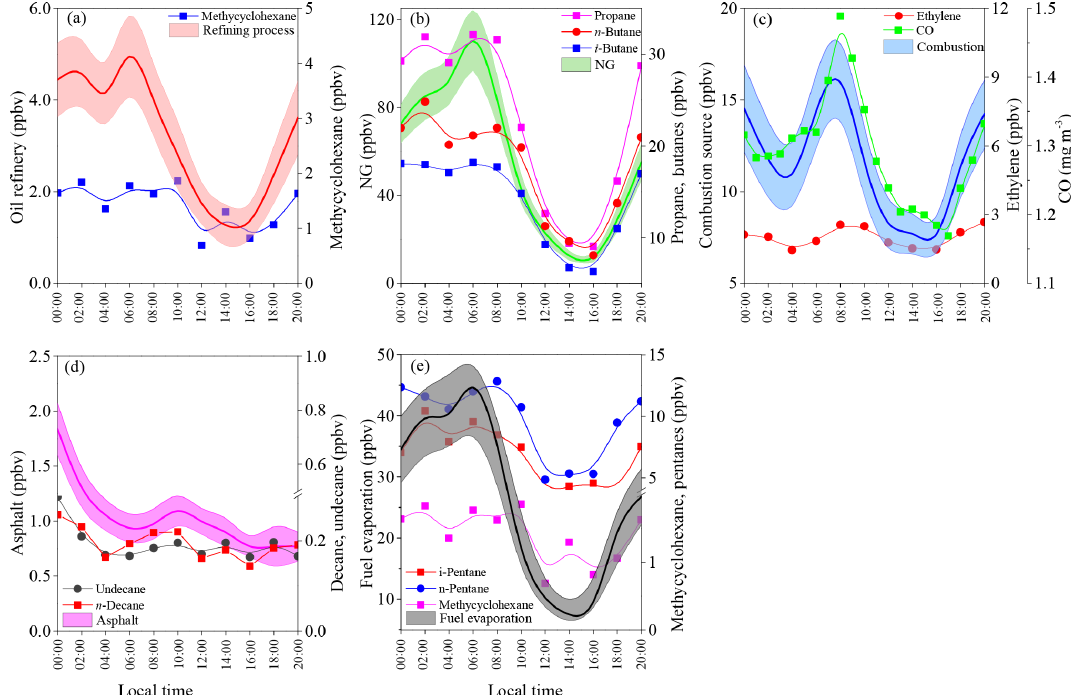
Figure 13. Diurnal variation in the contributions (ppbv) of five identified sources including oil refining processes (a) , NG (b) , combustion source (c) , asphalt (d) , and fuel evaporation (e) and specific compounds with high loadings in each source profile. Note that the CO in combustion source is expressed in milligrams per cubic